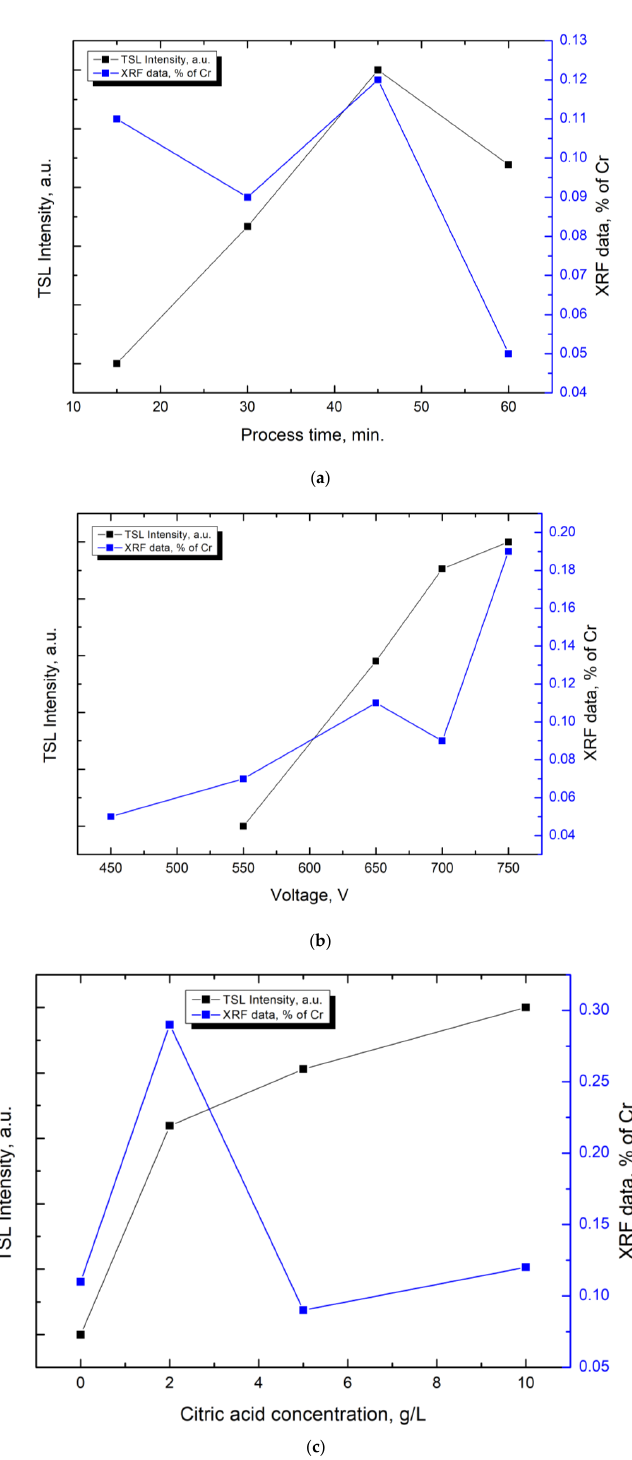
Figure 5. TSL intensity and XRF mass % of Cr based on: ( a ) different PEO process times at 700 V voltage and 10 g·L −1 citric acid concentration; ( b ) different PEO voltages at 30 min process time and 10 g·L −1 citric acid concentration; ( c ) different citric acid concentrations in PEO electrolyte at 700 V voltage and 45 min process time.